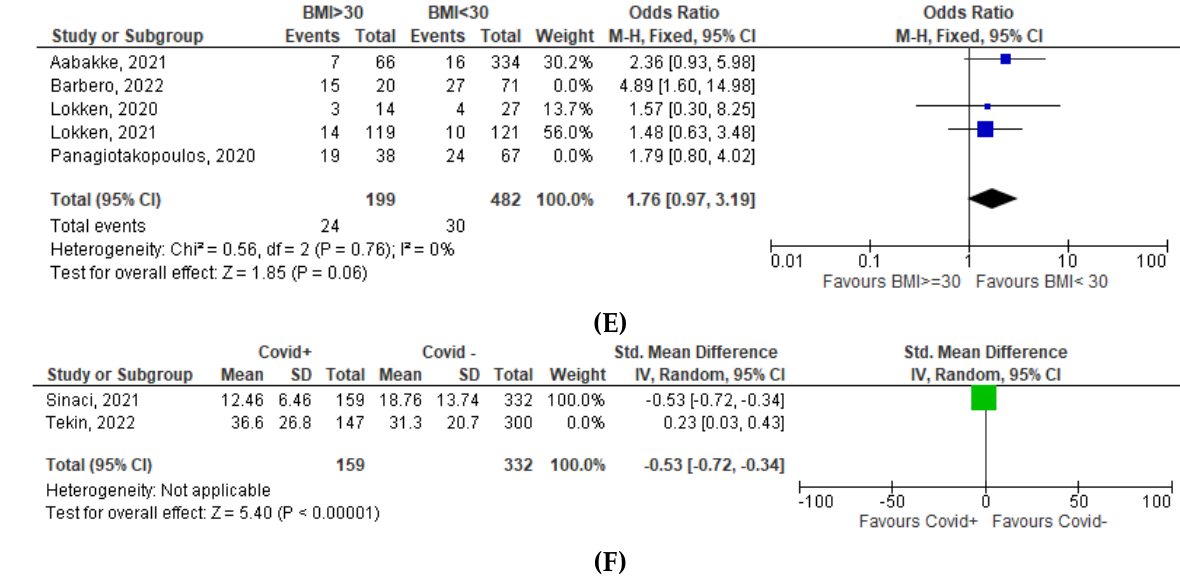
Figure A1. ( A ) Sensitivity analysis including small sample size studies (<100 per arm) and using a